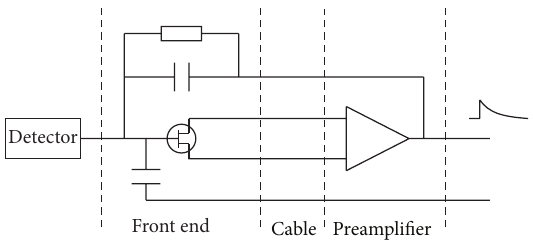
Figure 7: A high-level illustration of the signal readout scheme for each detector channel (see text for details on this readout design and the typical values for the